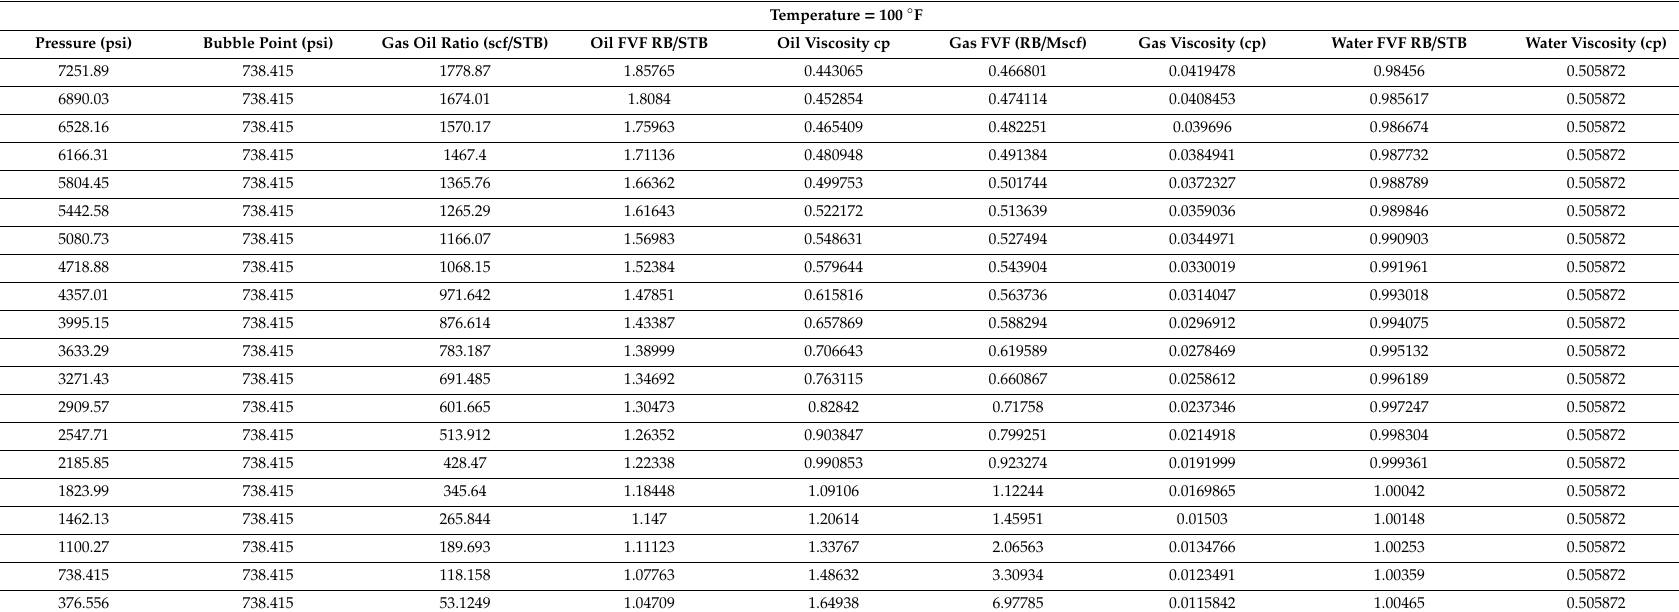
Table A4. PVT properties at 100 ◦ F.